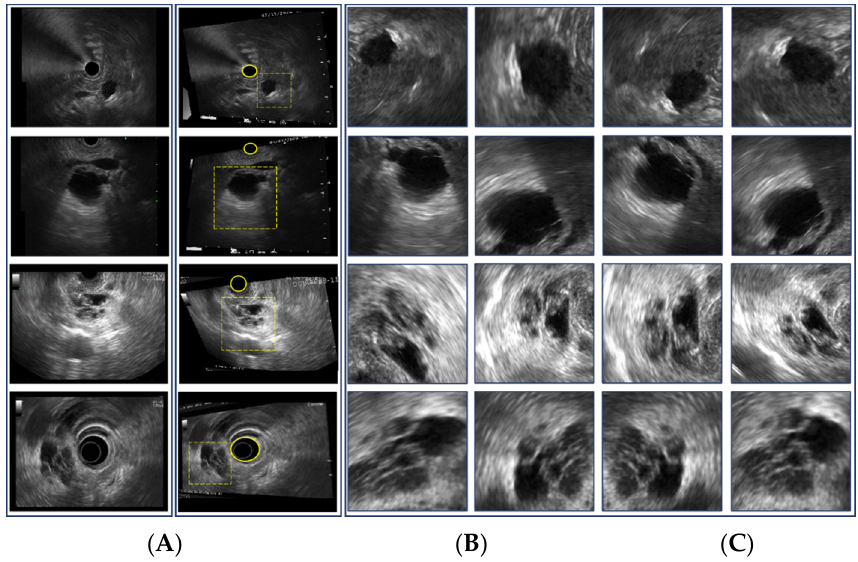
Figure 5. Examples of data augmentation for training data. ( A ) Original EUS image, ( B ) image after perspective transformation, ( C ) selected ROIs. The yellow circle in ( B ) represents the circular or semicircular hollow region owing to the EUS probe, while the dotted square in ( B ) represents examples of ROI selection.